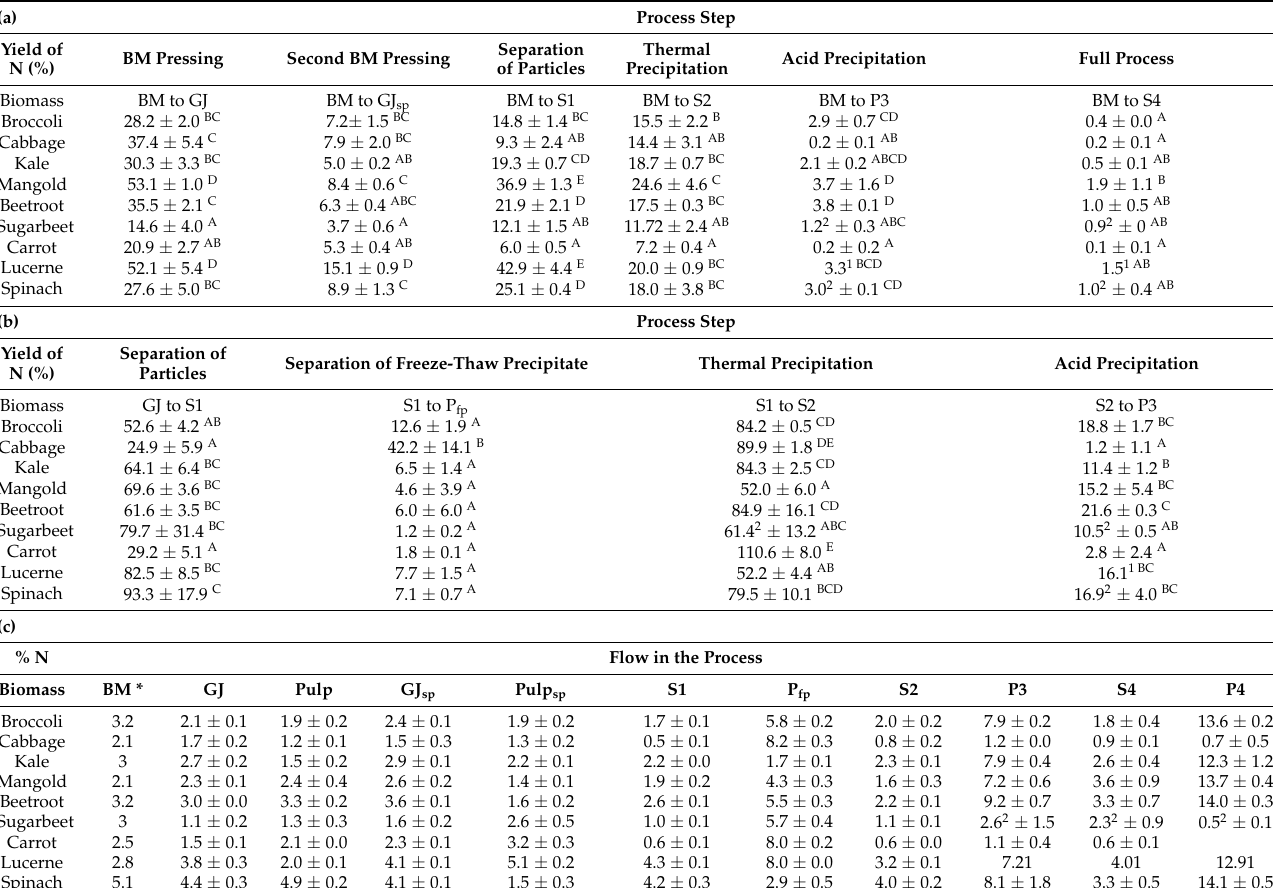
Table 2. ( a ) Yield (%) of nitrogen (N) relative to N content in initial biomass (BM) in the different process steps (see Figure 2). Mean of three process replicates (unless otherwise indicated by superscript numbers). ( b ) Yield (%) of N relative to the ingoing material for each process step. ( c ) N content (%) on a dry matter basis (average of replicates) of the flows in the extraction process. Different letters (A–D) indicate significant differences ( p < 0.05) in yield. Superscript numbers indicate numbers of replicates if not triplicates. GJ: green juice, GJ sp : green juice from the second press, S1: particle-free green juice, P fp : pellet with freeze-thaw precipitate, S2: supernatant after thermal treatment, P3: acid-precipitated white protein, S4: resolubilized protein fraction, P4: insoluble